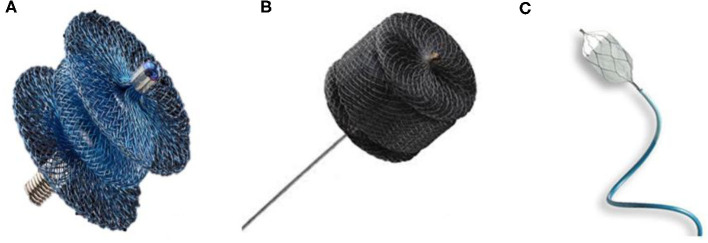
Devices generally used for percutaneous PDA closure in premature babies. (A) Amplatzer Ductus Occluder II Additional Sizes / Piccolo Occluder (Abbott). (B) Amplatzer vascular plug II (Abbott). (C) MVP Microvascular Plug (Medtronic).